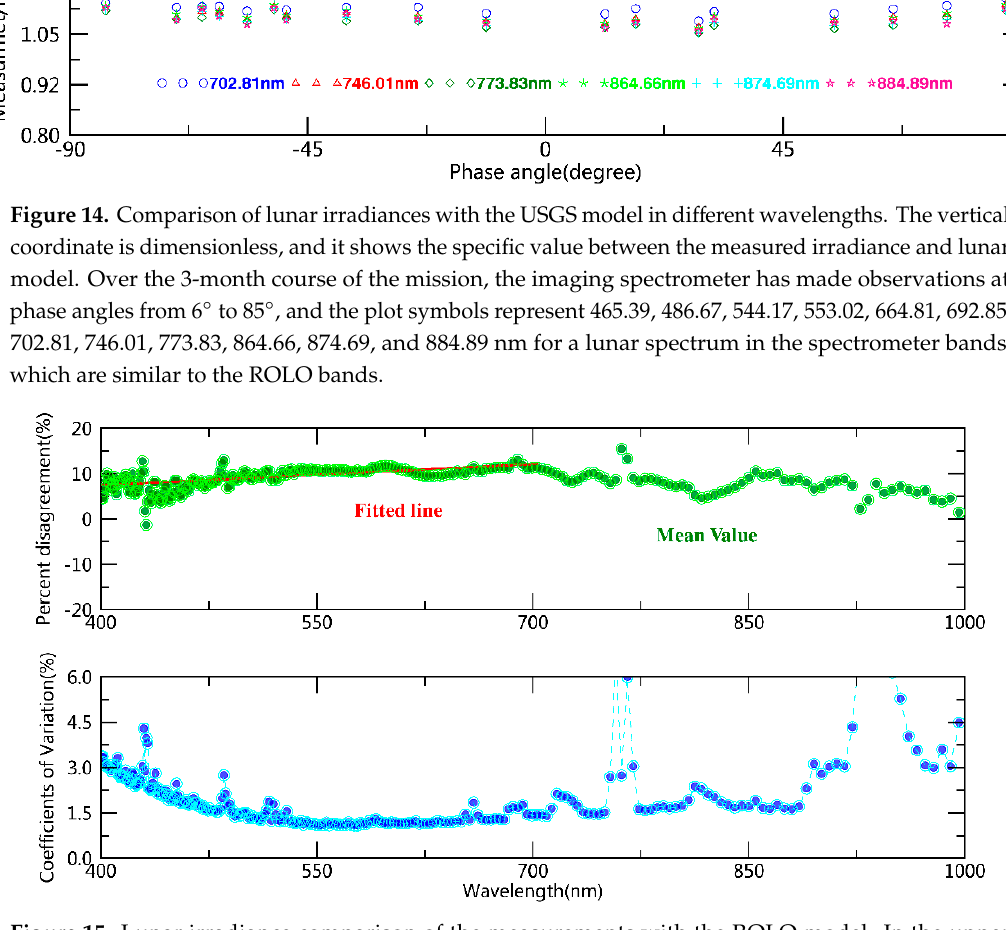
Figure 15. Lunar irradiance comparison of the measurements with the ROLO model. In the upper panel, the plot ordinate is the mean discrepancy between the measured lunar irradiance and lunar model output and expressed as a percentage difference from unity. The fitting line from 400 to 700 nm is a red-dotted line. In the bottom panel, the plot ordinate is the coefficients of variation of percent disagreement.